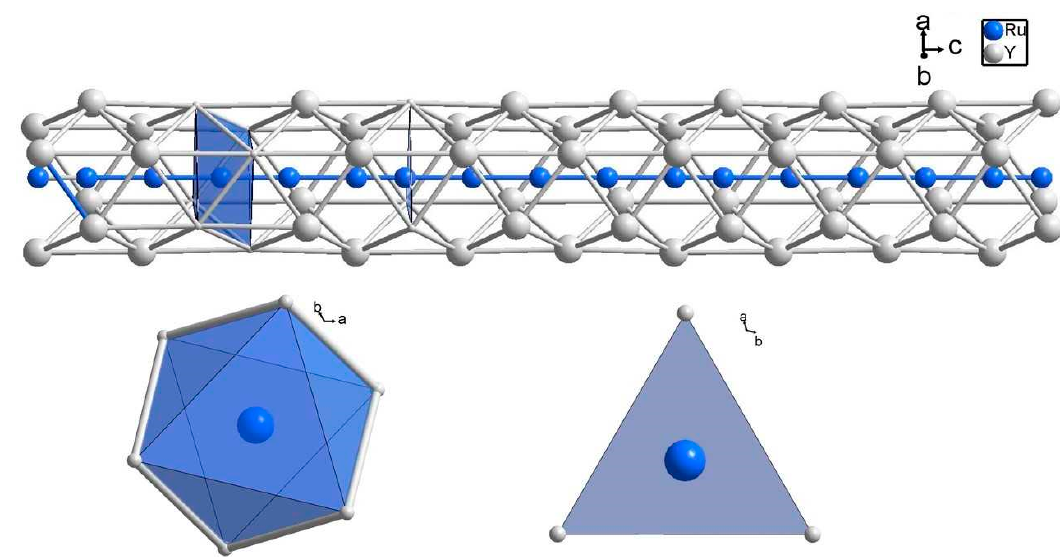
Figure 3. The chain formed by the Ru atoms of the second sub cell (Ru2, blue) in the trigonal antiprismatic surroundings of the Y atoms from the first sub cell. Note the continuous change of local environment for Ru2 from planar trigonal to compressed octahedral.